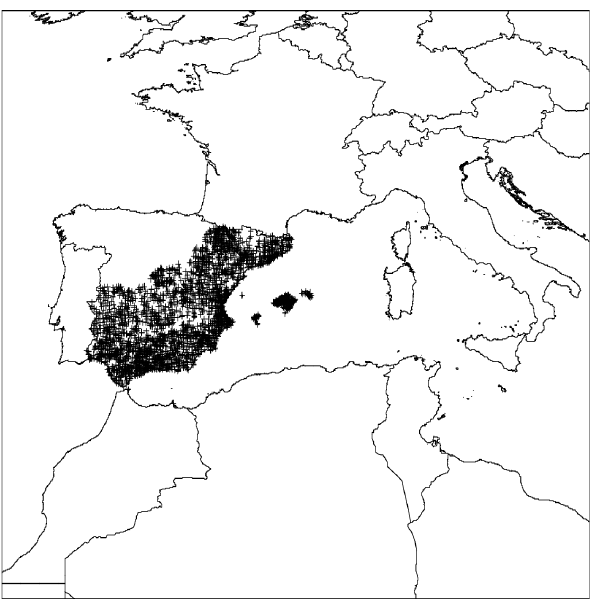
Fig. 2. ROC area for the multiphysics ensemble control member, the multiphysics ensemble mean, the bias corrected ensemble mean and the superensemble, as functions of different rainfall event